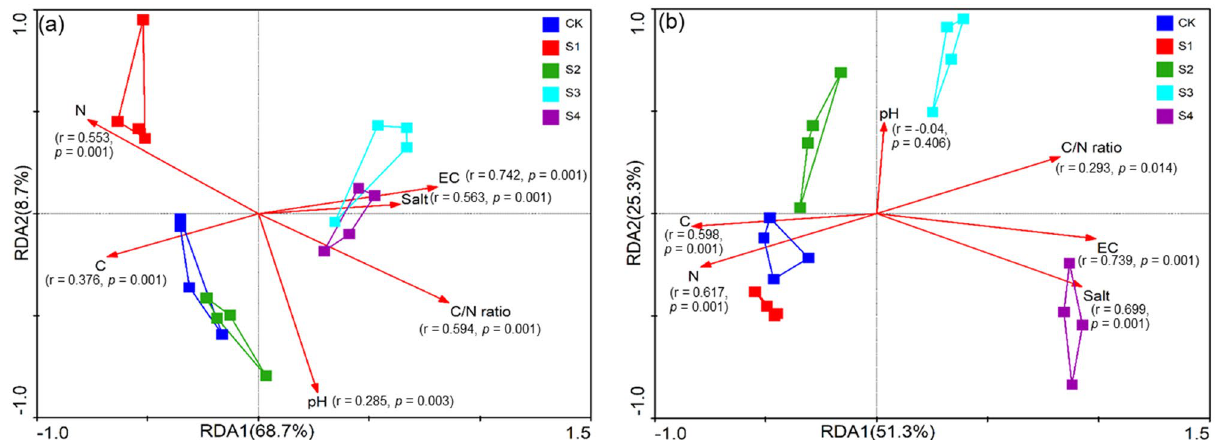
Figure 3. The RDA plots showing the effects of soil physiochemical properties (pH, EC, salt content, TC, TN, and C/N ratio) on the bacterial community structure at phylum level ( a ) and Shannon diversity ( b ). The significance of the effect of each property was examined using the Mantel test (permutation = 999), and the significance was evaluated by the r- and p -values.